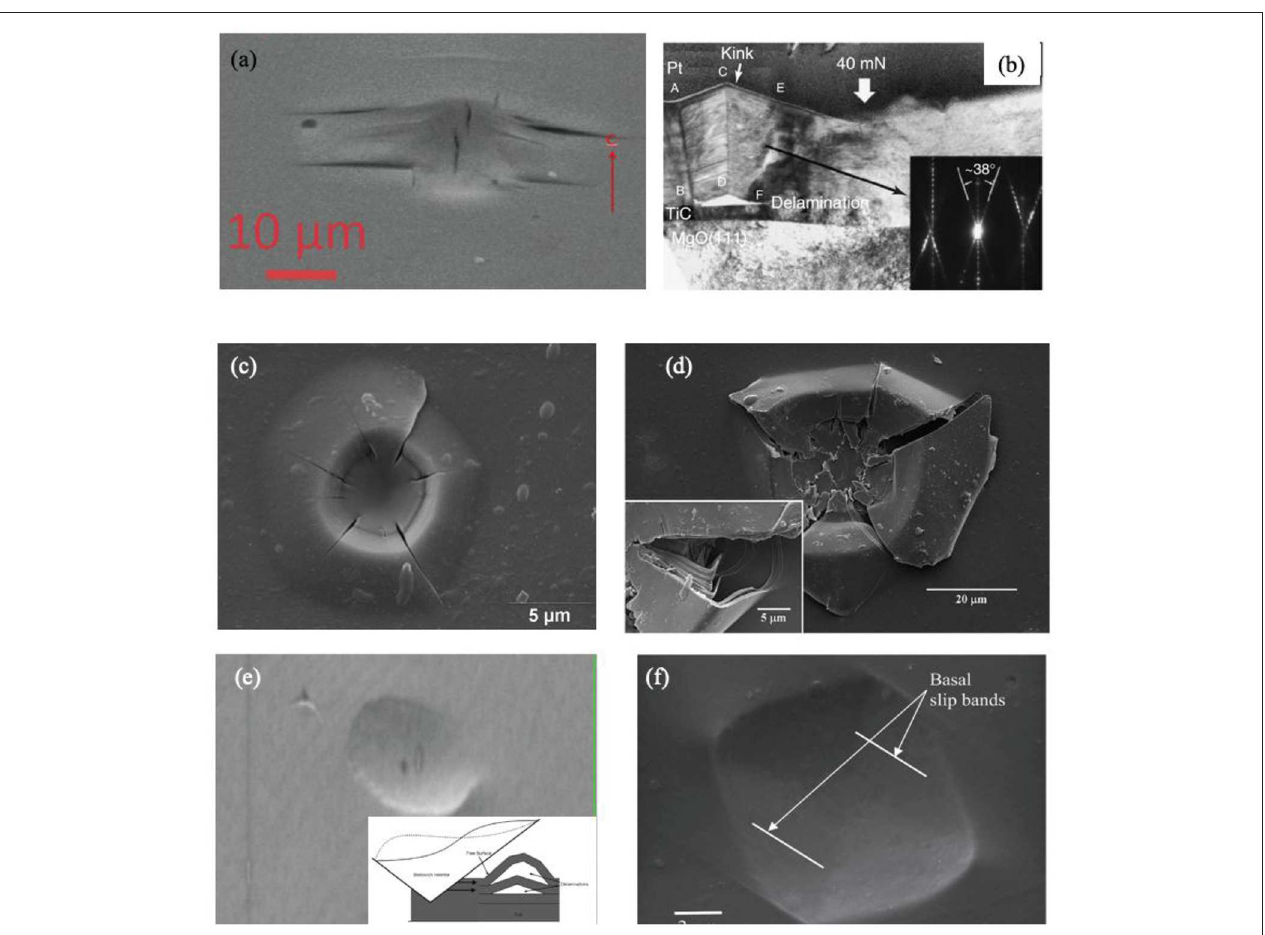
FIGURE 6 | Nanoindentation marks in, (a) SEM micrograph of a spherical NI in (10 ¯ 10) Ti 3 SiC 2 grain (Murugaiah et al., 2004). (b) TEM cross-sectional micrograph of a Berkovich indentation in a thin Ti 3 SiC 2 epitaxial layer (Molina-Aldareguia et al., 2003). (c) same as (a) but in a (000l) MAX single crystal, (d) same as (c) but for mica. In both a large pileup around indenter is observed. (e) (000l) Mg (Griggs, 2016) and, (f) (10 ¯ 10) ZnO (Basu and Barsoum, 2007). Inset in e is schematic of how basal planes buckle to create pileups. (a,f) reproduced with permission from J. Mater. Res., Cambridge Univ. Press.